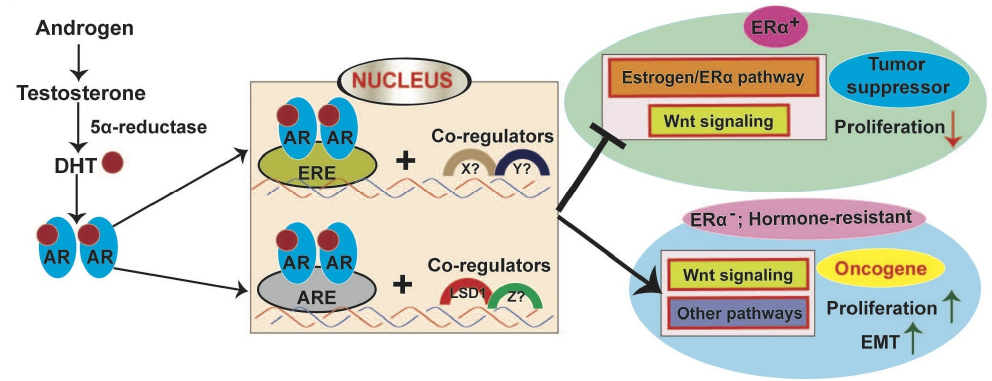
Figure 5. Proposed roles of AR and WNT signaling in mammary gland development and breast cancer. In breast cells, activated androgen/AR binds to ARE or ERE in its target genes. In ER α + cells, it largely works as a tumor suppressor by inhibiting estrogen/ER α signaling and/or WNT signaling; in ER α − cells or even in ER α + cells that have become resistant to hormone therapy (targeting the estrogen/ER pathway), AR may function as an oncoprotein by activating WNT signaling and/or other oncogenic pathways. Under different cellular contexts, AR may utilize different co-regulators (e.g., LSD1, or other co-regulators remain to be defined (X?, Y?, or Z?)) to control distinct downstream programs.